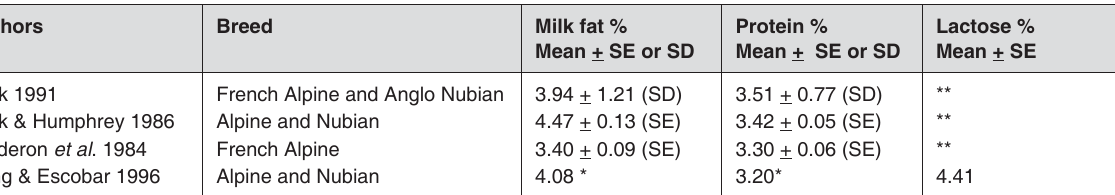
TABLE 1 Compositional quality of goat milk for different breeds